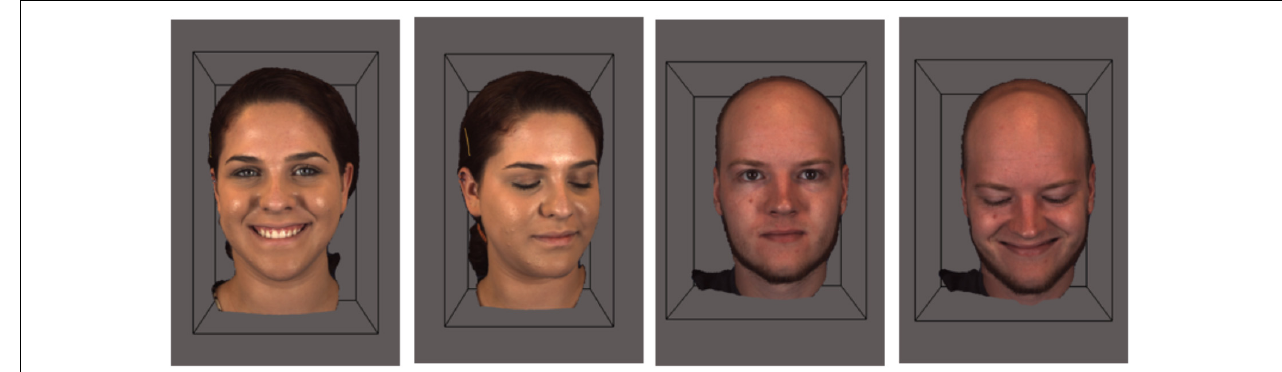
FIGURE 5 | BP-4D-S facial database presented on gray background with bounding box representing a 3D depth plane (The images pictured above were reproduced, modified and adapted from the facial database originally developed by Zhang et al. (2013, 2014). Copyright 2013–2017, The Research Foundation for the State University of New York and University of Pittsburgh of the Commonwealth System of Higher Education. All Right Reserved. BP4D-Spontaneous Database, as of: 26/03/2018. 3D faces are built on-screen as models with a geometric mesh in a three-dimensional plane; presenting an anatomically accurate modeled object with width, height and depth. This is captured by the 3D camera set-up. This reconstruction by computer-scientists is highly individualized, but is typically underlined by a geometric mesh or structure. The 3D surface features of the individual are then rendered. As the face moves around in 3D space, it becomes apparent why having three dimensions maintains facial structure more realistically than a facial model built with only two dimensions, as indicated by the depth